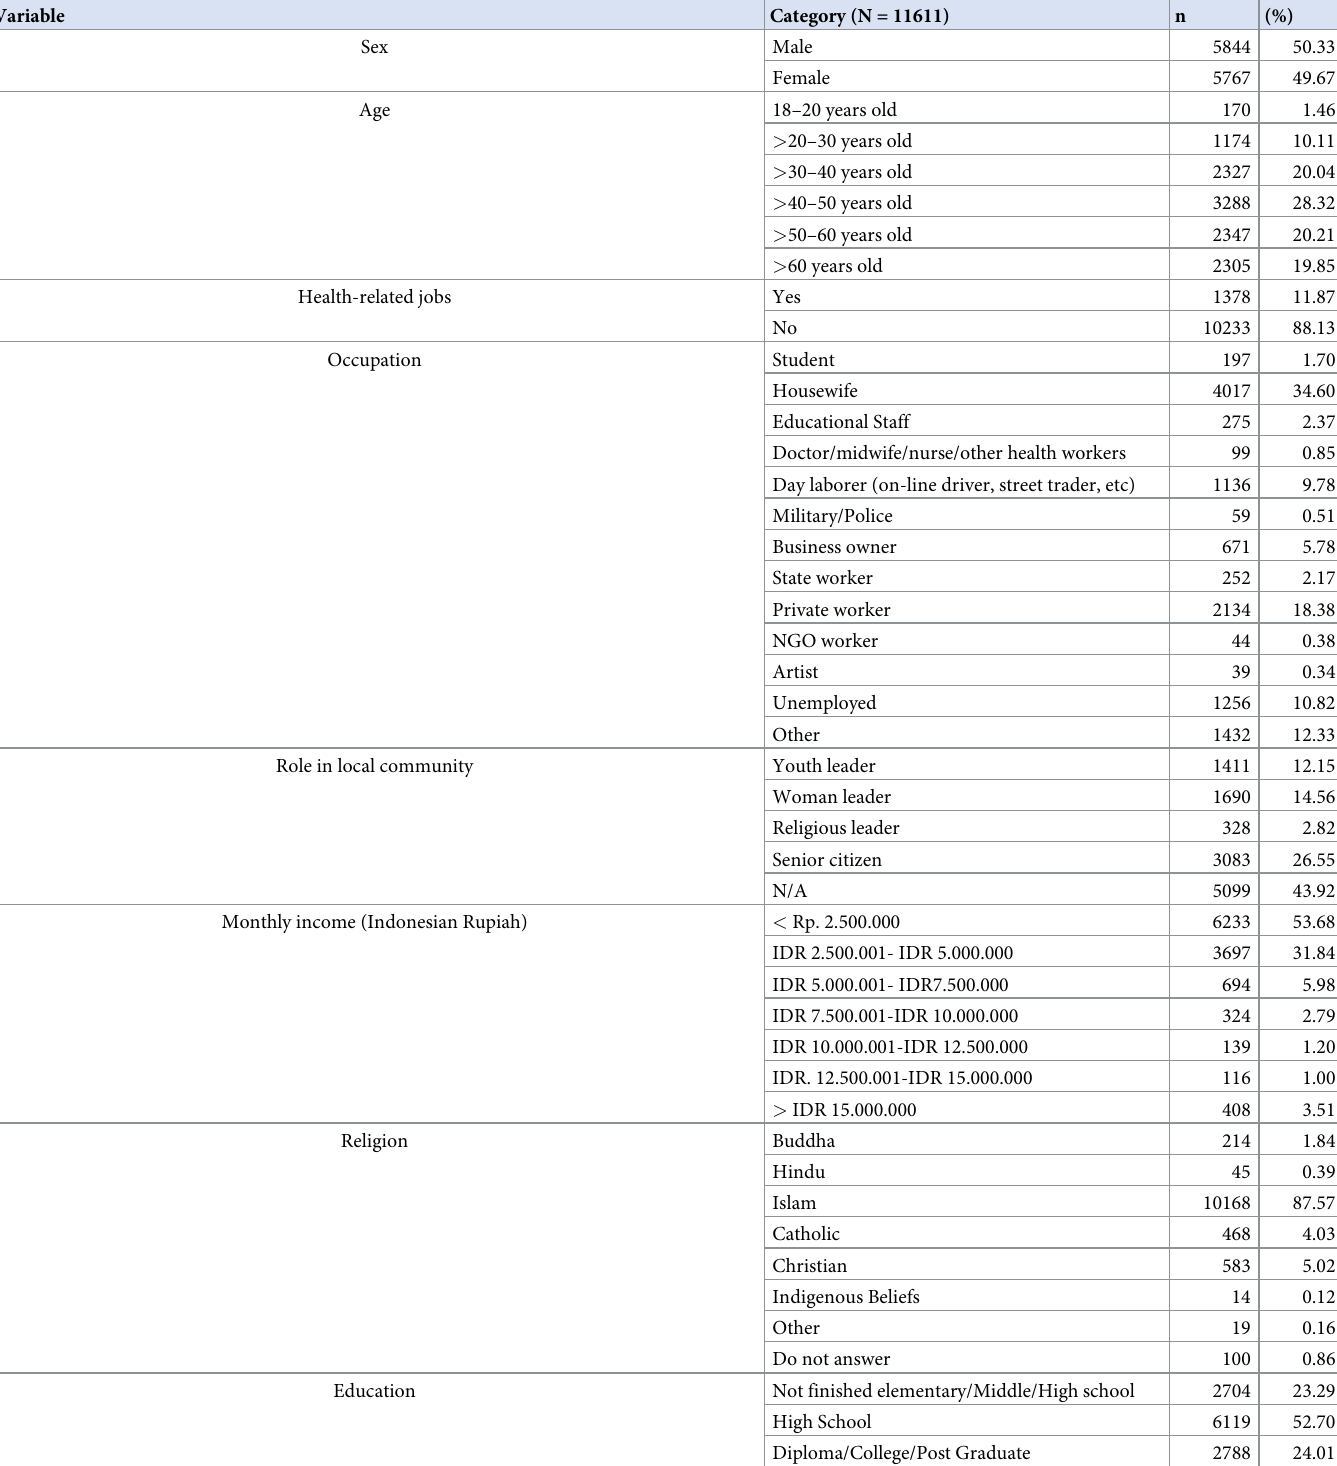
Table 1. Demographic characteristics of study